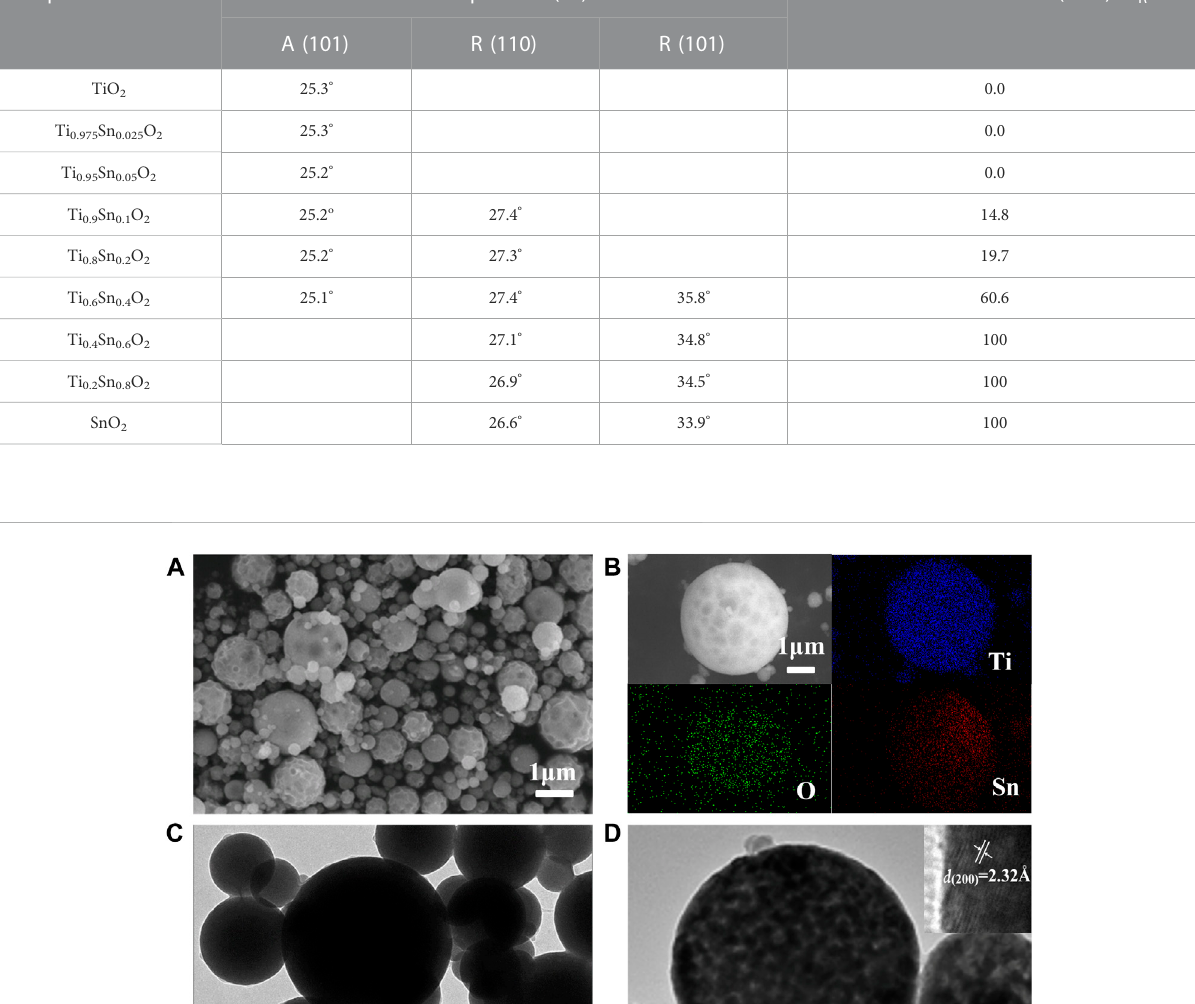
TABLE 1 The summary of lattice parameters of (101), rutile (110) and (101) plane from anatase lattice; and mass fraction of rutile phase (W R ). Sample